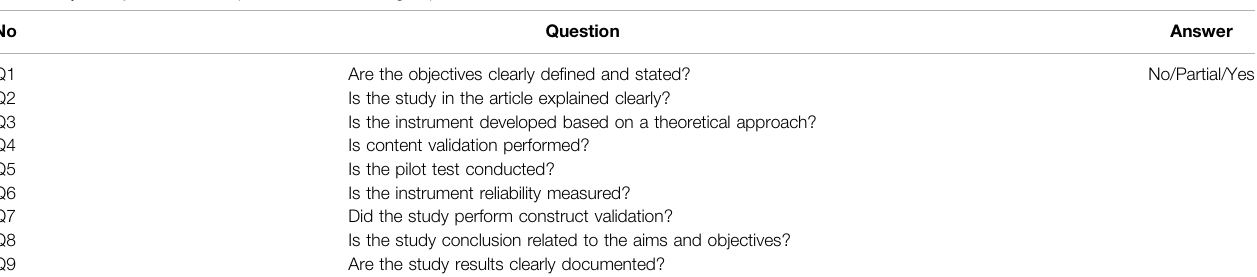
TABLE 9 | Quality assessment questions for the IDV group.